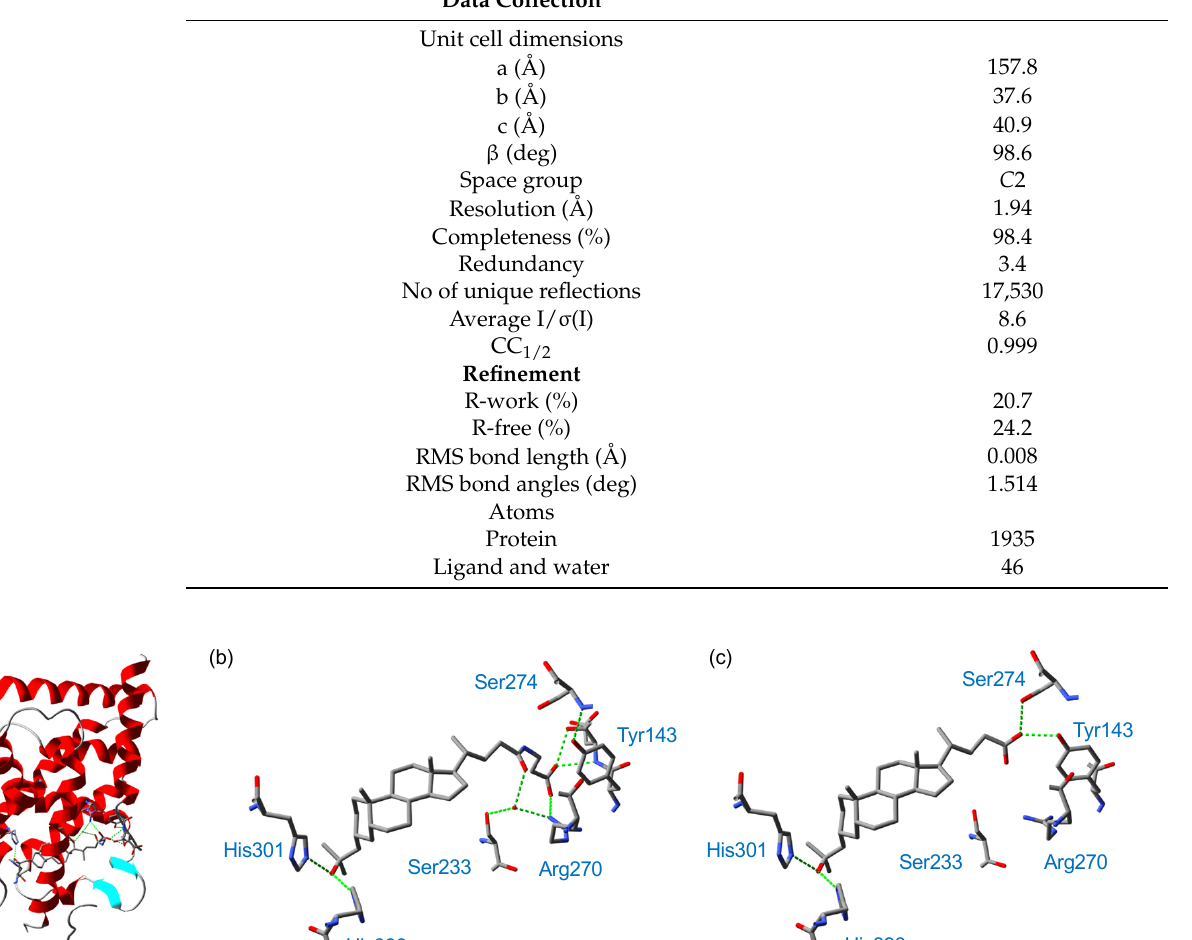
Table 2. Data collection and refinement statistics for the crystal structure of VDR LBD bound to 7b and coactivator peptide. Values in parentheses are for the highest-resolution shell.